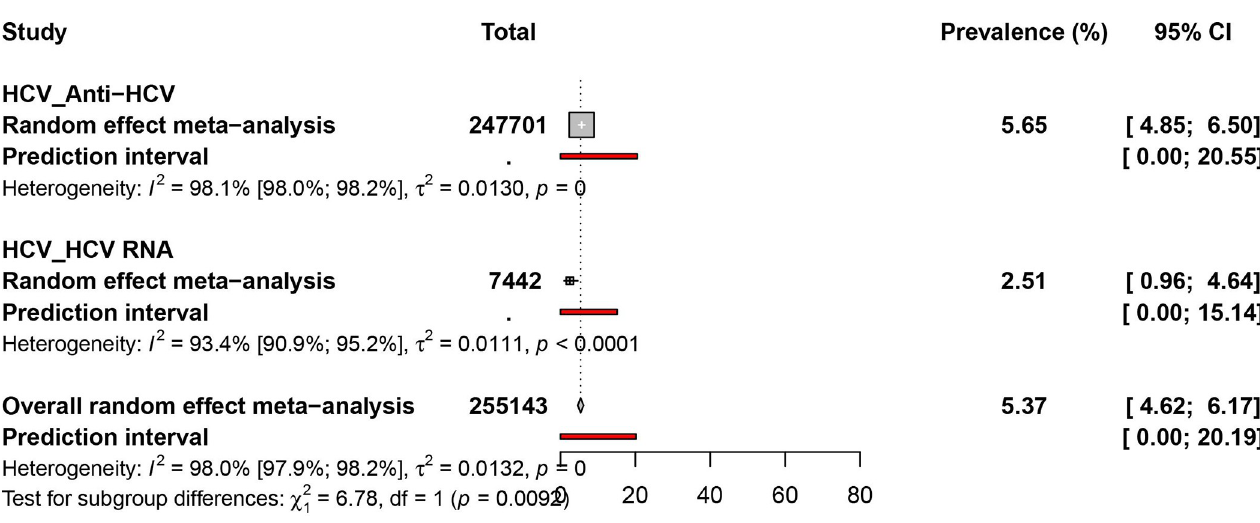
Fig 5. Prevalence estimate of hepatitis C virus infection in PLHIV in